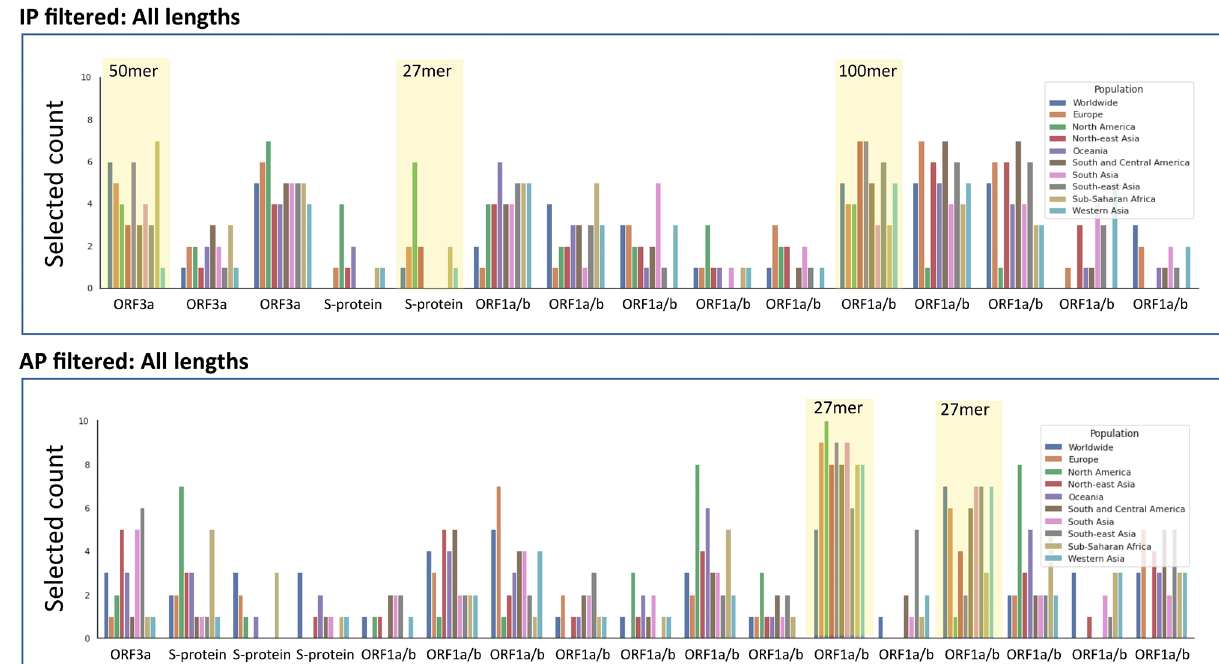
Figure 7. The plot illustrates a set of digital twin simulation experiments to identify effective epitope hotspots based on immune presentation (IP) and antigen presentation (AP), which broadly cover the population. The aim of the analysis was to select an optimum set of hotspots (respecting a given budget) such that the likelihood that each citizen (in a given modelled population) has a positive response is maximized (or, equivalently, that the log likelihood of no response for each citizen is minimized). Ten simulations were run for each region illustrated, where each simulation consisted of 10,000 digital twins (see supplementary file for more details). This plot shows the number of times each hotspot was selected for use in one of the simulations. Each hotspot selected at least 10 times is shown on the x-axis, and the y-axis shows the selected counts per region. Each bar corresponds to a different region-specific simulation setting. A subset of 5 hotspots were selected based on their profile across the AP and IP digital twin analyses, which could theoretically provide coverage of > 90% across a global population (highlighted in